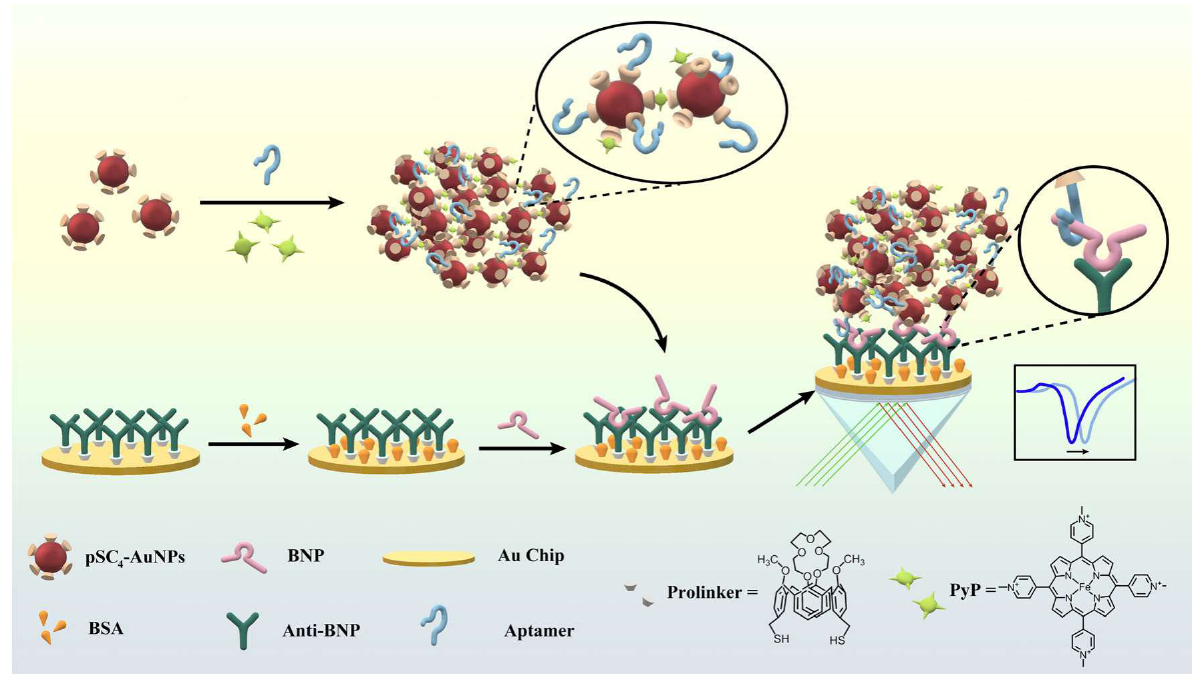
Figure 1. A schematic diagram of the bionanonetworks based on organic compounds and inorganic nanoparticles as an SPR signal amplification strategy for BNP detection (Reprinted with permission from Ref. [32]. Copyright 2016, Microchimica Acta).